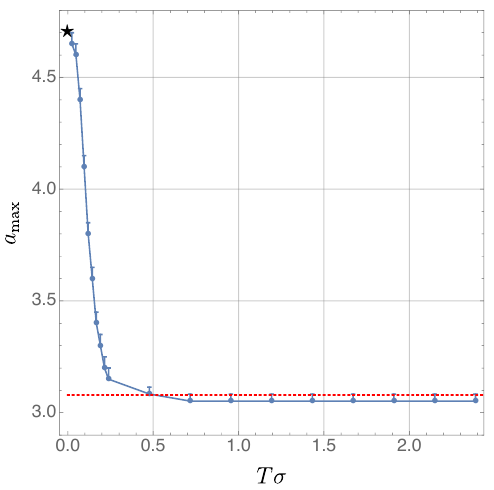
Figure 15 . a max as a function of T , computed for n = 4. The black star is the T = 0 result and the dotted red line is a ergo